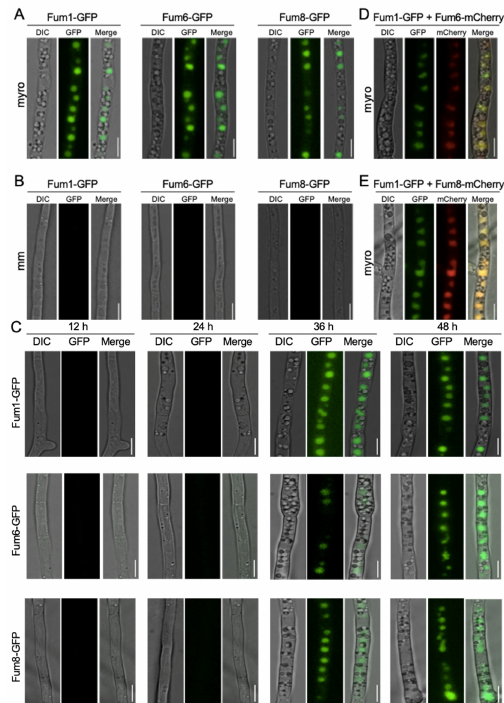
Figure 1. Localization of Fum1, Fum6, and Fum8 in hyphae in toxin inducing and non-inducing media . ( A ) Fum1-GFP, Fum6-GFP, and Fum8-GFP are localized to the spherical structures in hy- phae grown in the toxin inducing medium (myro). ( B ) GFP signals were not detected in the minimal medium (mm). All images were taken after 48 h incubation at 28 °C with constant shaking. ( C ) Localization of three key Fum proteins grown in myro broth at different time points (12, 24, 36, 48 h). ( D ) Fum6-mCherry co-localized with Fum1-GFP in hyphae grown in myro liquid medium ( E ) Fum8- mCherry co-localized with Fum1-GFP in myro liquid medium. Bar = 5 µ